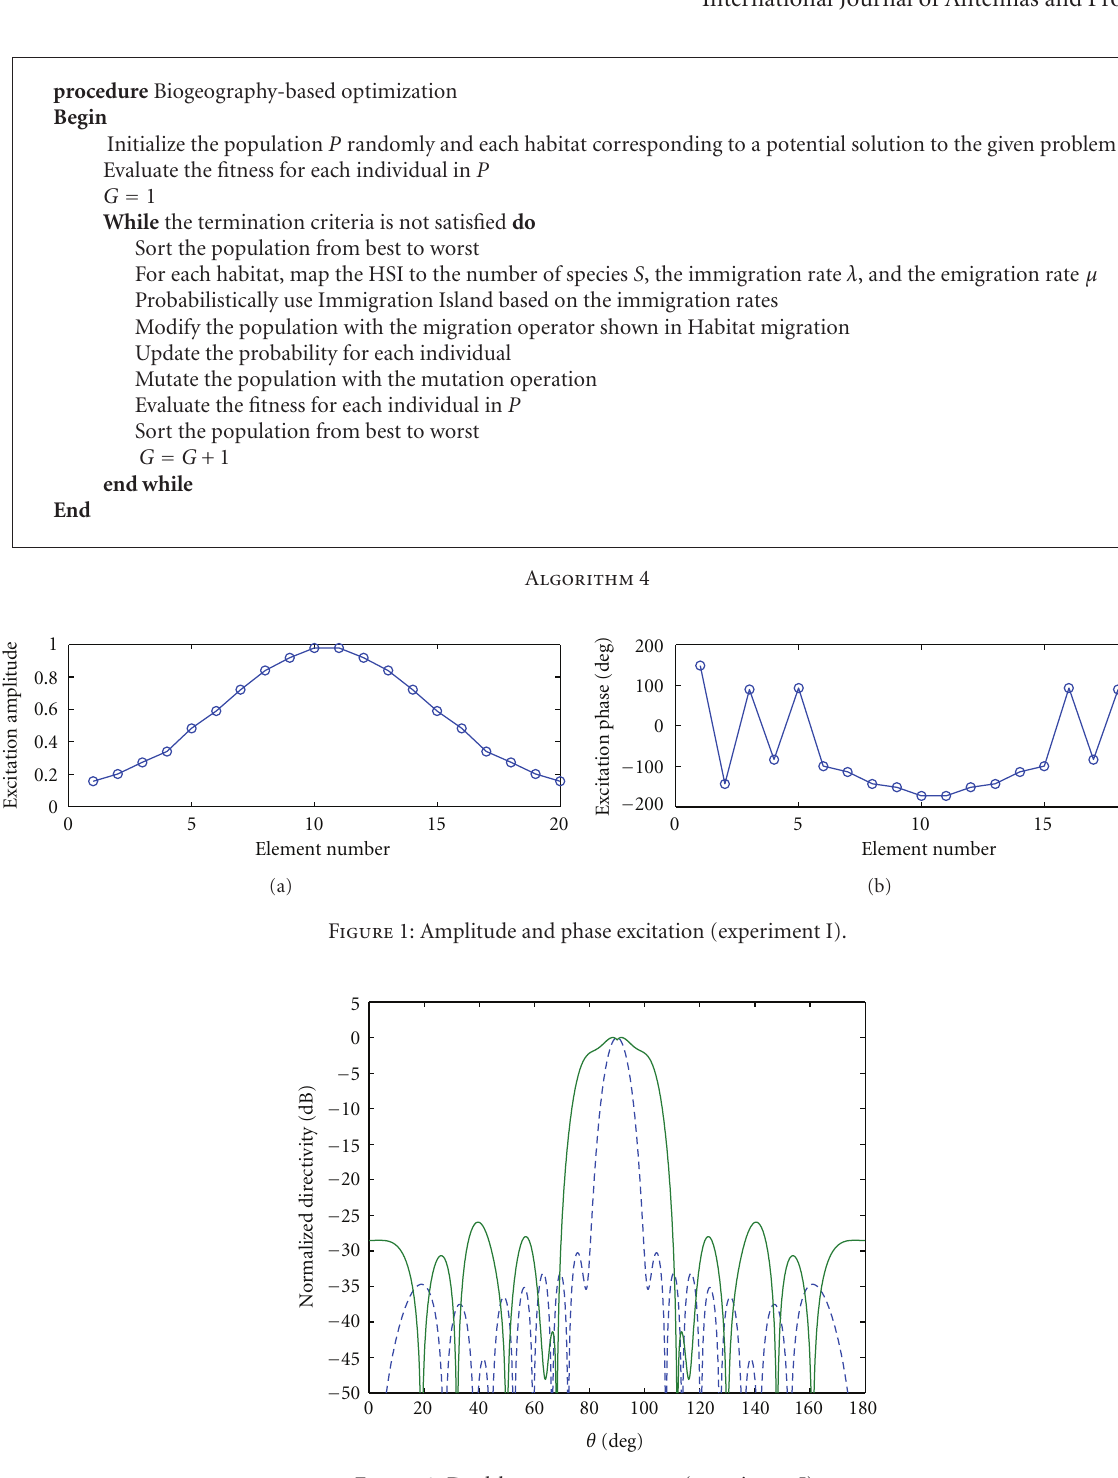
Figure 2: Dual-beam array patterns (experiment